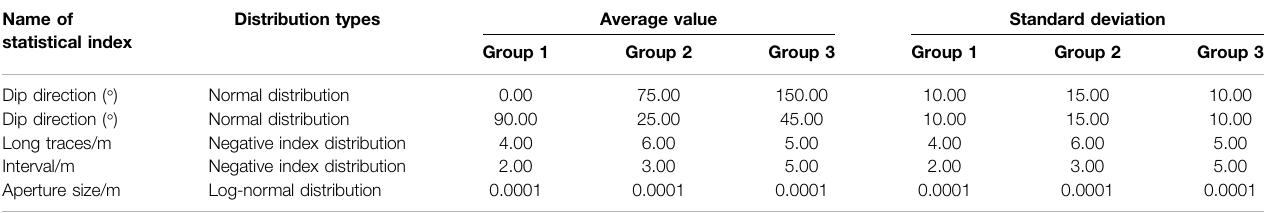
TABLE 1 | Statistical parameters of the fracture